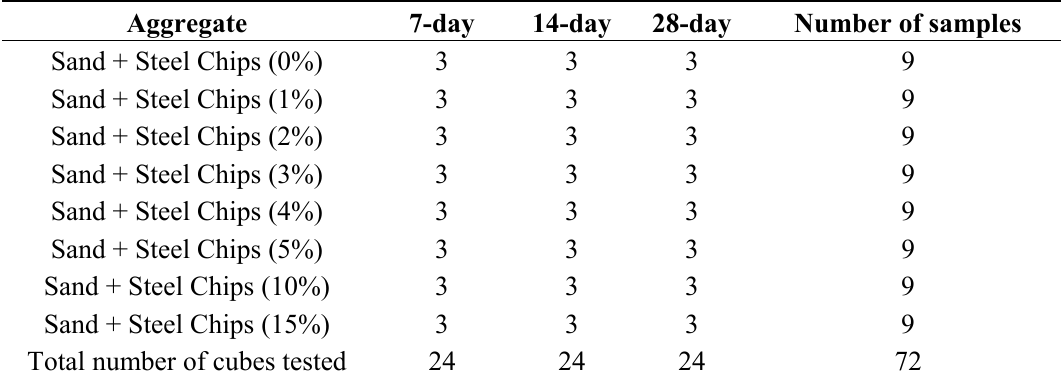
Table 2. Number of cubes at the various testing periods.